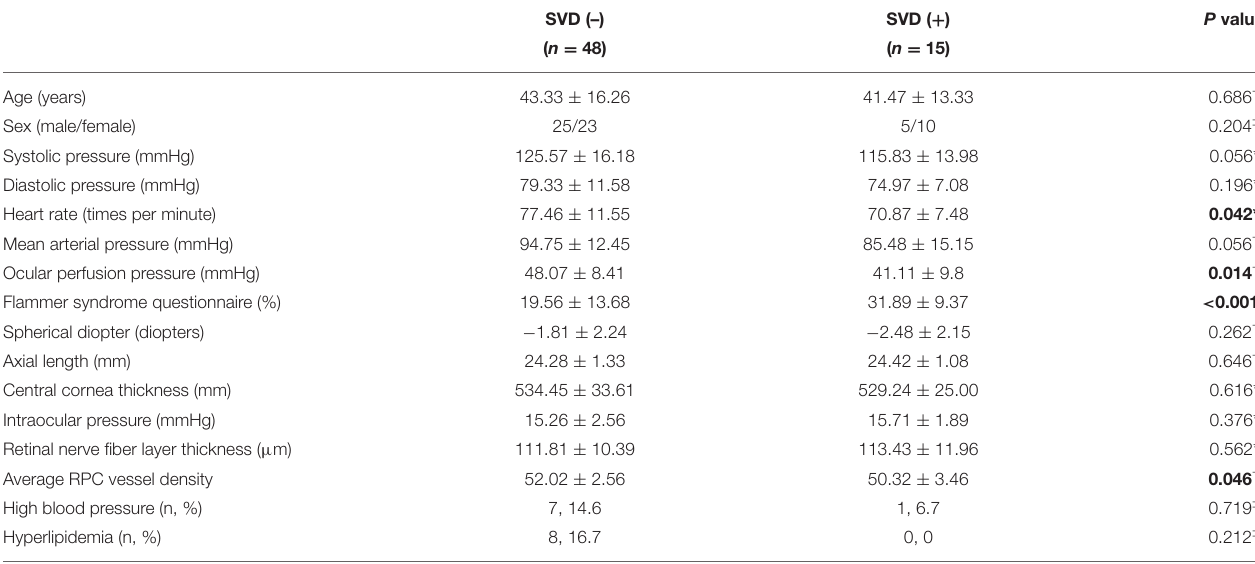
TABLE 1 | Demographics and clinical